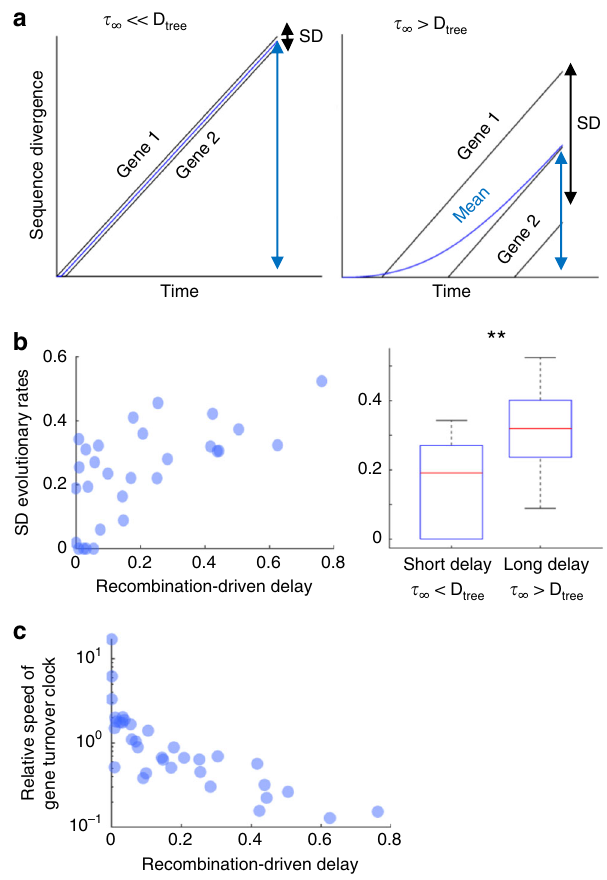
Fig. 4 : Recombination-driven delay leads to over-dispersion of evolutionary rates within taxa and negatively correlates with gene turnover rate. a The divergence of individual genes (black lines) grows linearly after the establishment of barriers to gene conversion, whereas the overall divergence (blue lines) grows non-linearly as the barriers spread across the genome. The mean (blue arrows) and standard deviation (black arrows) of the gene-speci fi c divergences are determined by the values of the recombination-driven delay ( τ ∞ ) and the tree depth (D tree ). b Standard deviations of the relative evolutionary rates (corrected by gene-wise and taxon-wise rates) as a function of the recombination-driven delay (left). Each data point corresponds to one of the taxa from Fig. 3. Correlation coef fi cient R = 0.64 (Pearson, p < 0.001, n = 34). On the right, boxplots of the standard deviation of relative evolutionary rates in linearly diverging ( τ ∞ > D tree ) and strongly delayed taxa ( τ ∞ « D tree ); center line, median; box limits, upper and lower quartiles; whiskers, 1.5× interquartile range; **statistically signi fi cant with p = 0.002 (two-tailed Student ’ s T test, 32 d.f.). c Negative association between the recombination-driven delays and the relative rates of gene turnover with respect to substitutions; Spearman ’ s correlation coef fi cient rho = − 0.86 (Spearman ’ s rank-order correlation p < 0.001, n = 34). Source data are provided as a Source Data fi